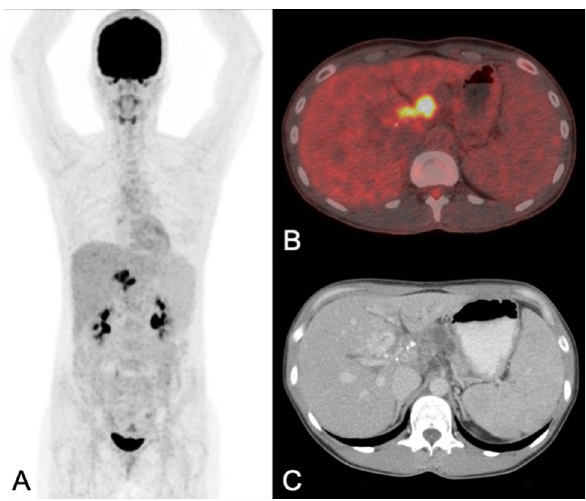
Figure 1. PET/CT performed for staging of alveolar echinococcosis in a 37-year old woman (patient 23 in Table 3) showed intense metabolic activity [in maximum intensity reconstructions of PET ( A ) and fused PET/ CT images ( B )] in a hilar lesion infiltrating the pancreas (dilated pancreatic duct on axial contrast-enhanced CT images in ( C ). SUVmax was 11.1 in the echinococcosis manifestation, and 3.1 in non-infected liver tissue; SUVratio was 3.6. After 1458 days of benzimidazole therapy, levels of Em-18 antibodies became undetectable, but therapy was not yet stopped at the end of the present study period (in total after 1633 days of therapy).